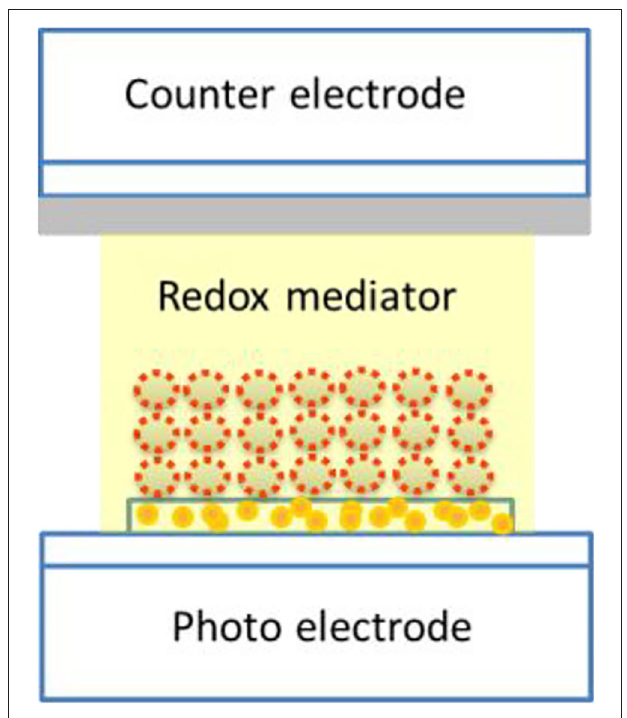
FIGURE 14 | Photoelectrode ITO; nano-TiO 2 layer and then the dye sensitizer, e.g., humic substance; and counter Pt electrode and a redox mediator I − 3 /I– sandwiched between the two electrodes in a Graetzel solar cell. Illumination from the bottom and the electric current was